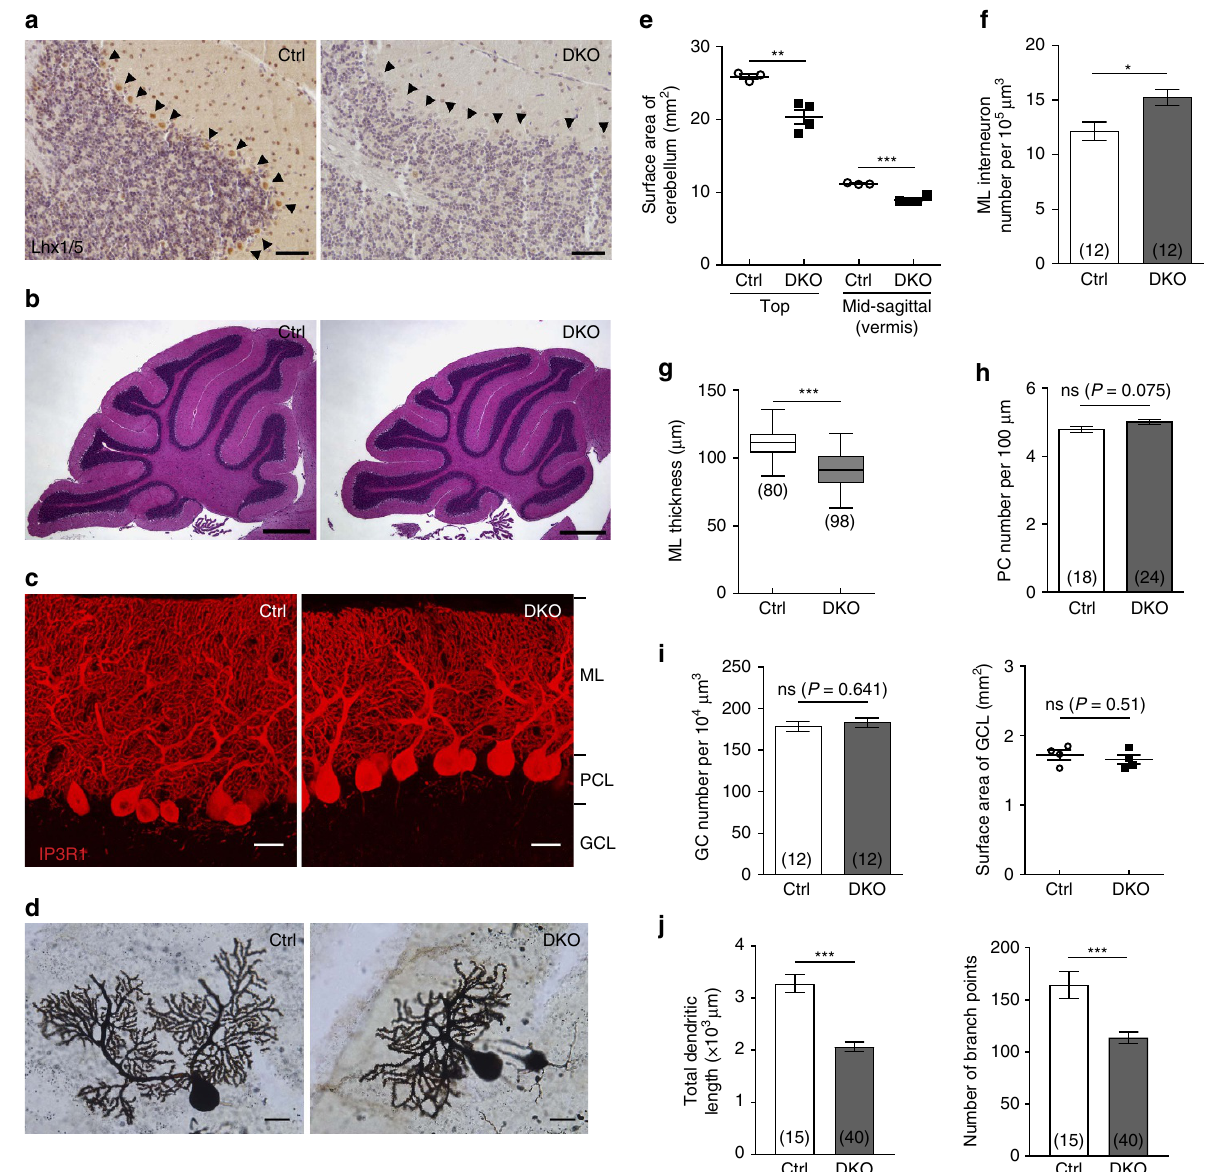
Figure 1 | Normal cytoarchitecture of cerebellum but reduced length of PC dendrites in Lhx1/5 DKO mutants. ( a ) Immunostaining of Lhx1/5 in the PCs (arrowheads) of the control (Ctrl) (left) and the DKO mutant (right). Scale bars, 50 m m. ( b ) Haematoxylin and eosin (H&E) staining showing the cytoarchitecture and foliation of the cerebellum of the control (left) and the DKO mutant (right). Scale bars, 500 m m. ( c ) Immunostaining of IP3R1 showing the PCs of the control (left) and the DKO mutant (right). ML, molecular layer; PCL, Purkinje cell layer; GCL, granule cell layer. Scale bars, 20 m m. All immunostaining or staining experiments were replicated at least three times with at least three mice per genotype. ( d ) Golgi-impregnated PCs of the control (Ctrl) (left) and the DKO mutant (right). Scale bars, 20 m m. ( e ) Scatter plot showing the size of cerebellum decreased in the DKO mutants (measured by the surface area of cerebellum at different views as shown in Supplementary Fig. 2b). ( f ) Bar graph showing that the density of interneurons in ML increased in the DKO mutants. ( g ) Box plot showing that the DKO mutant cerebella had reduced molecular layer thickness in lobule IV–V. Boxes indicate the mean (middle line) and 25 to 75% range, while whiskers indicate maximum and minimum values. ( h ) Bar graph showing the density of PCs was comparable between the mutants and the controls. ( i ) Bar graph (left) showing the density of GCs and scatter plot (right) showing the surface area of GCL (measured by the GCL area in H&E staining shown in ( b )) was comparable between the mutants and the controls. ( j ) Bar graphs showing the total dendritic length (left) and the branching number (right) of the Golgi-impregnated PCs. Values in the brackets indicate the number of sections analysed. For all scatter plots, the bars indicate the mean values and each point represents a mouse cerebellum. For each measurement, at least three mice were analysed per group; t -test; ns, not significant; * P o 0.05, ** P o 0.01 and *** P o